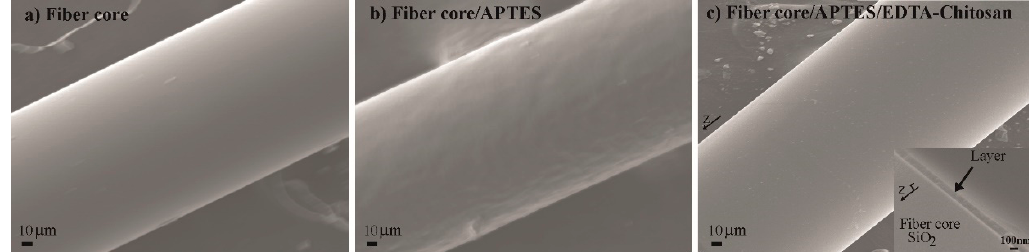
Figure 3. Atomic force microscope (AFM) image of ( a ) silica surface; ( b ) APTES-treated silica surface; ( c ) surface functionalized with chitosan conjugated EDTA.